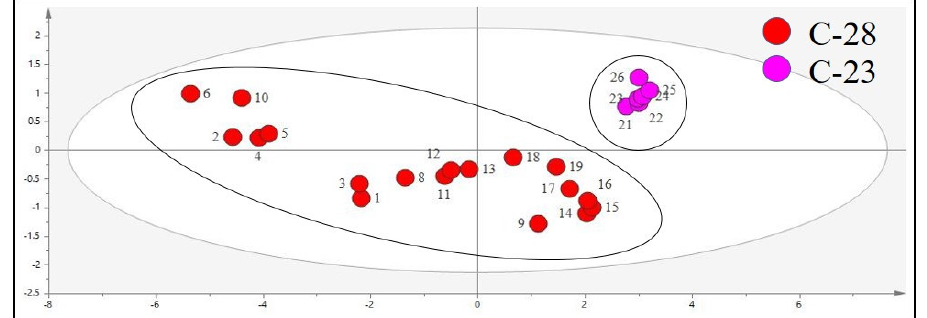
Figure 4. PLS-DA of combining position on HepG2. C-28—pyrazine was added at the C-28 position; C-23—pyrazine was added at the C-23 position.